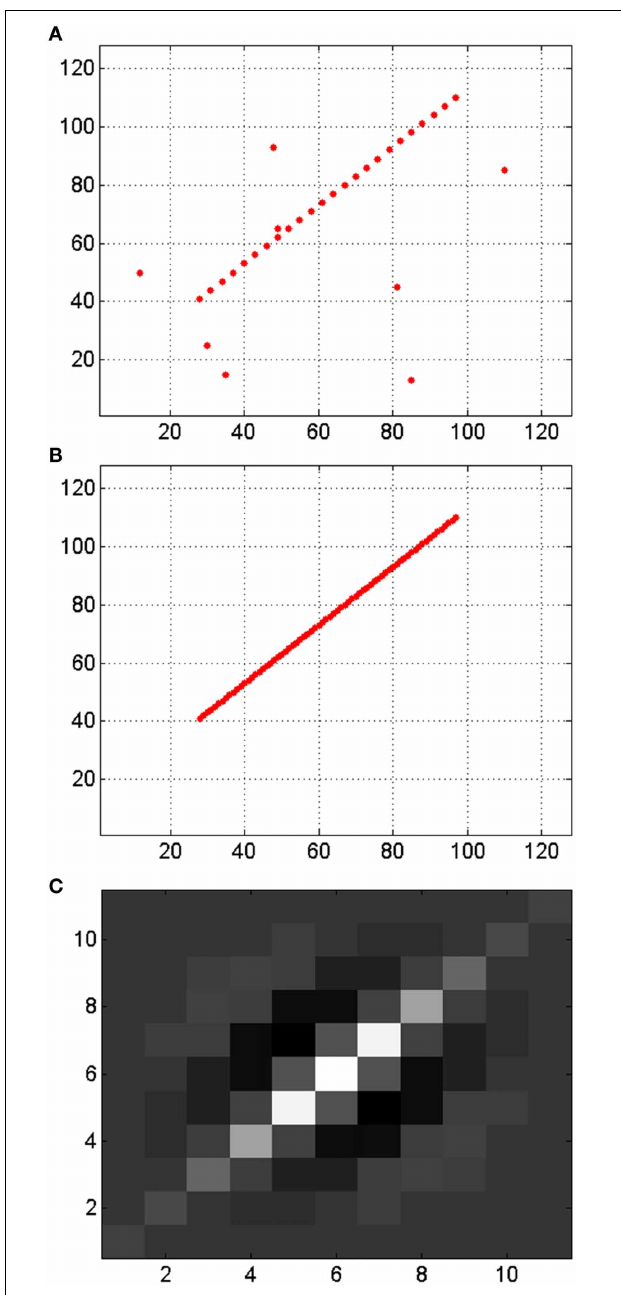
FIGURE 13 | Illustration of enhancing edges and noise reduction by a Gabor filter. (A) Input events representing a discontinuous edge with noise. (B) Output events generated by the Gabor filter, with the reconstructed edge without noise. (C) Gabor kernel. All axes represent pixels, being the visual space in (A,B) 128 × 128 and the size of the kernel in (C) 11 × 11.